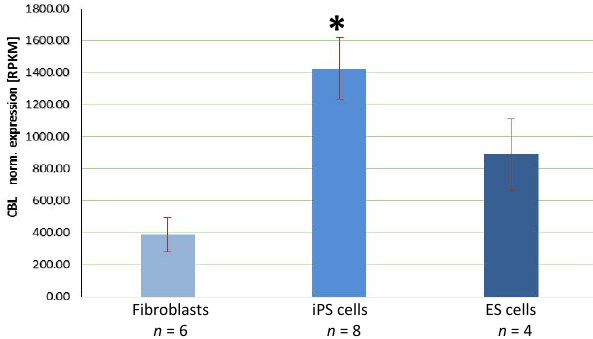
Figure 2. Normalized c-CBL transcript abundance in marmoset fibroblasts, iPS cells and ES cells. The expression levels are ex- pressed as Reads Per Kilobase per Million mapped reads (RPKM). ∗ p = 8.9 × 10 − 8 compared to